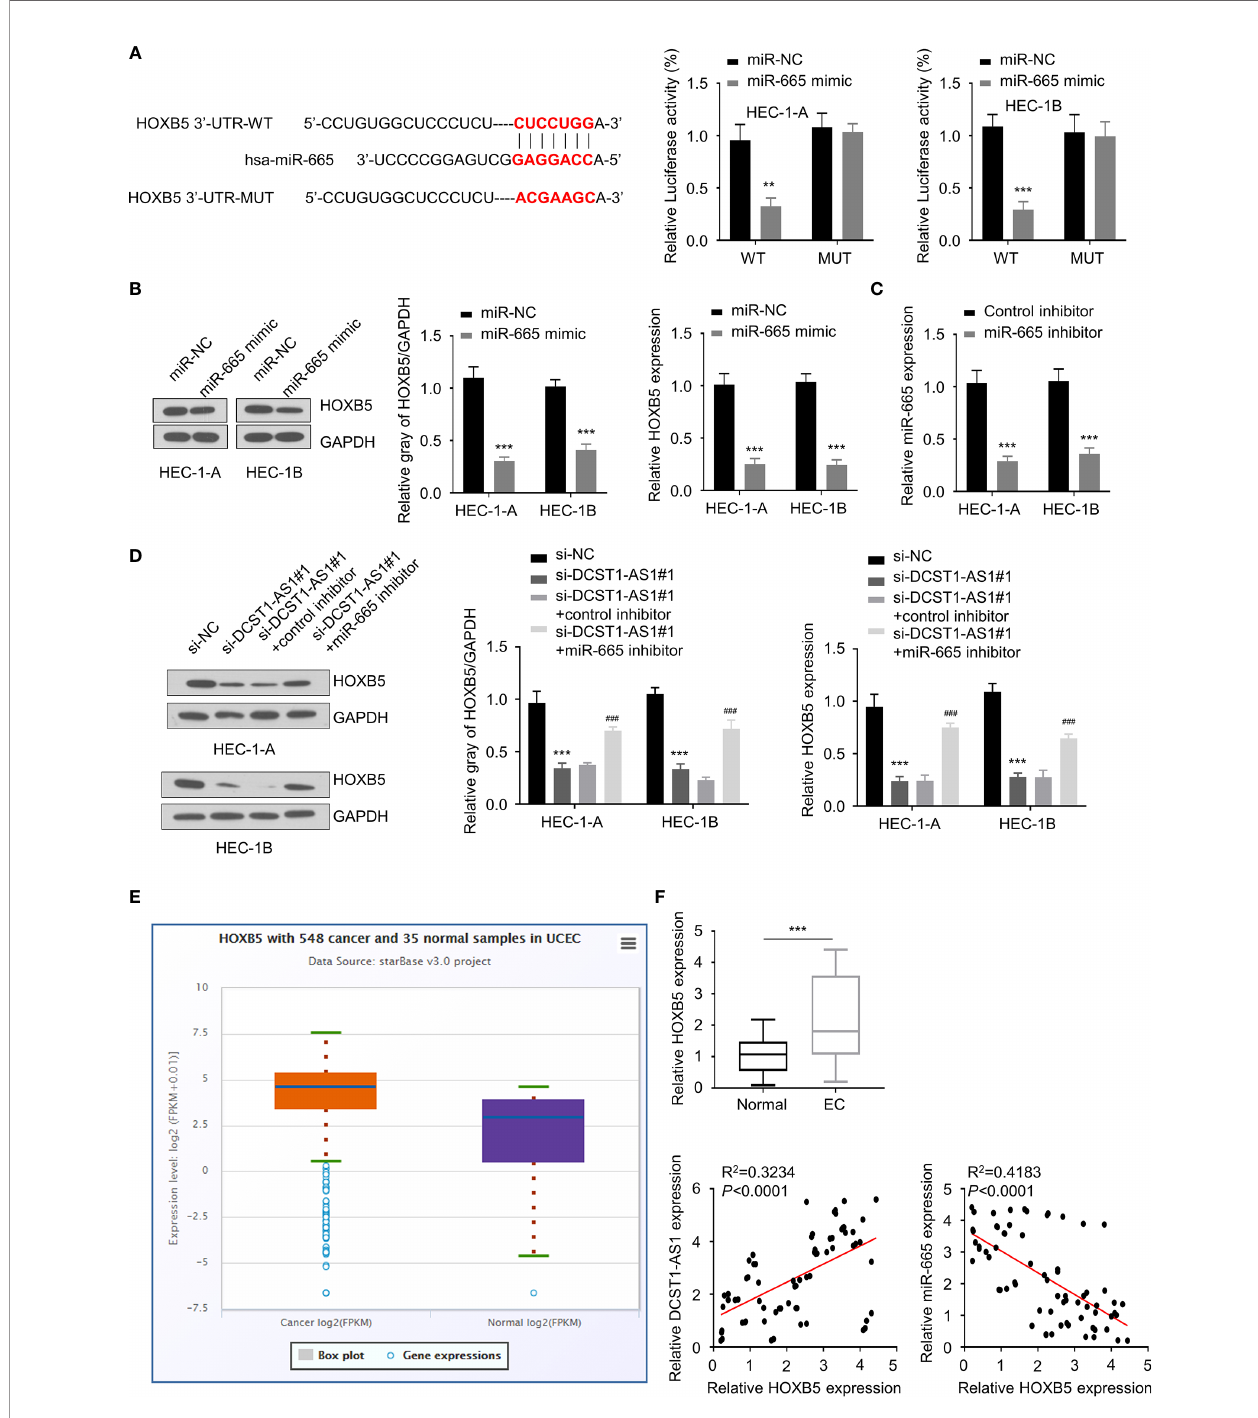
FIGURE 4 | LncRNA DCST1-AS1 sponges miR-665 to upregulate homeobox B5 (HOXB5) expression. (A) Predicted and mutant (lower panel) sequence alignments of miR-665 with HOXB5 3 ′ -UTR sequence. Luciferase reporter assays showed that miR-665 signi fi cantly reduced luciferase activity of WT HOXB5, but mutation of the miR-665 binding site abrogated the inhibitory effects of miR-665 (right panel). (B) The mRNA and protein levels of HOXB5 in EC cells transfected with miR-665 mimic or control mimic were examined using qRT-PCR assay and Western blot analysis. (C) The expression of miR-665 in EC cells transfected with miR-665 inhibitor or control inhibitor. (D) HEC-1A and HEC-1B cells were transfected as indicated, and the mRNA and protein expression of HOXB5 was investigated using qRT-PCR and Western blot analysis. (E) Comparison of HOXB5 expression in EC tissues ( n = 548) and normal tissues ( n = 35) (ENCORI database). (F) The mRNA expression of HOXB5 in 70 pairs of EC and adjacent normal tissues was checked using qRT-PCR assay. Spearman ’ s correlation analysis was used to analyze the relationship between HOXB5 expression and DCST1-AS1 or miR-665 expression. ** P < 0.01, *** P < 0.001. ### P < 0.001, compared with si-DCST1-AS1#1